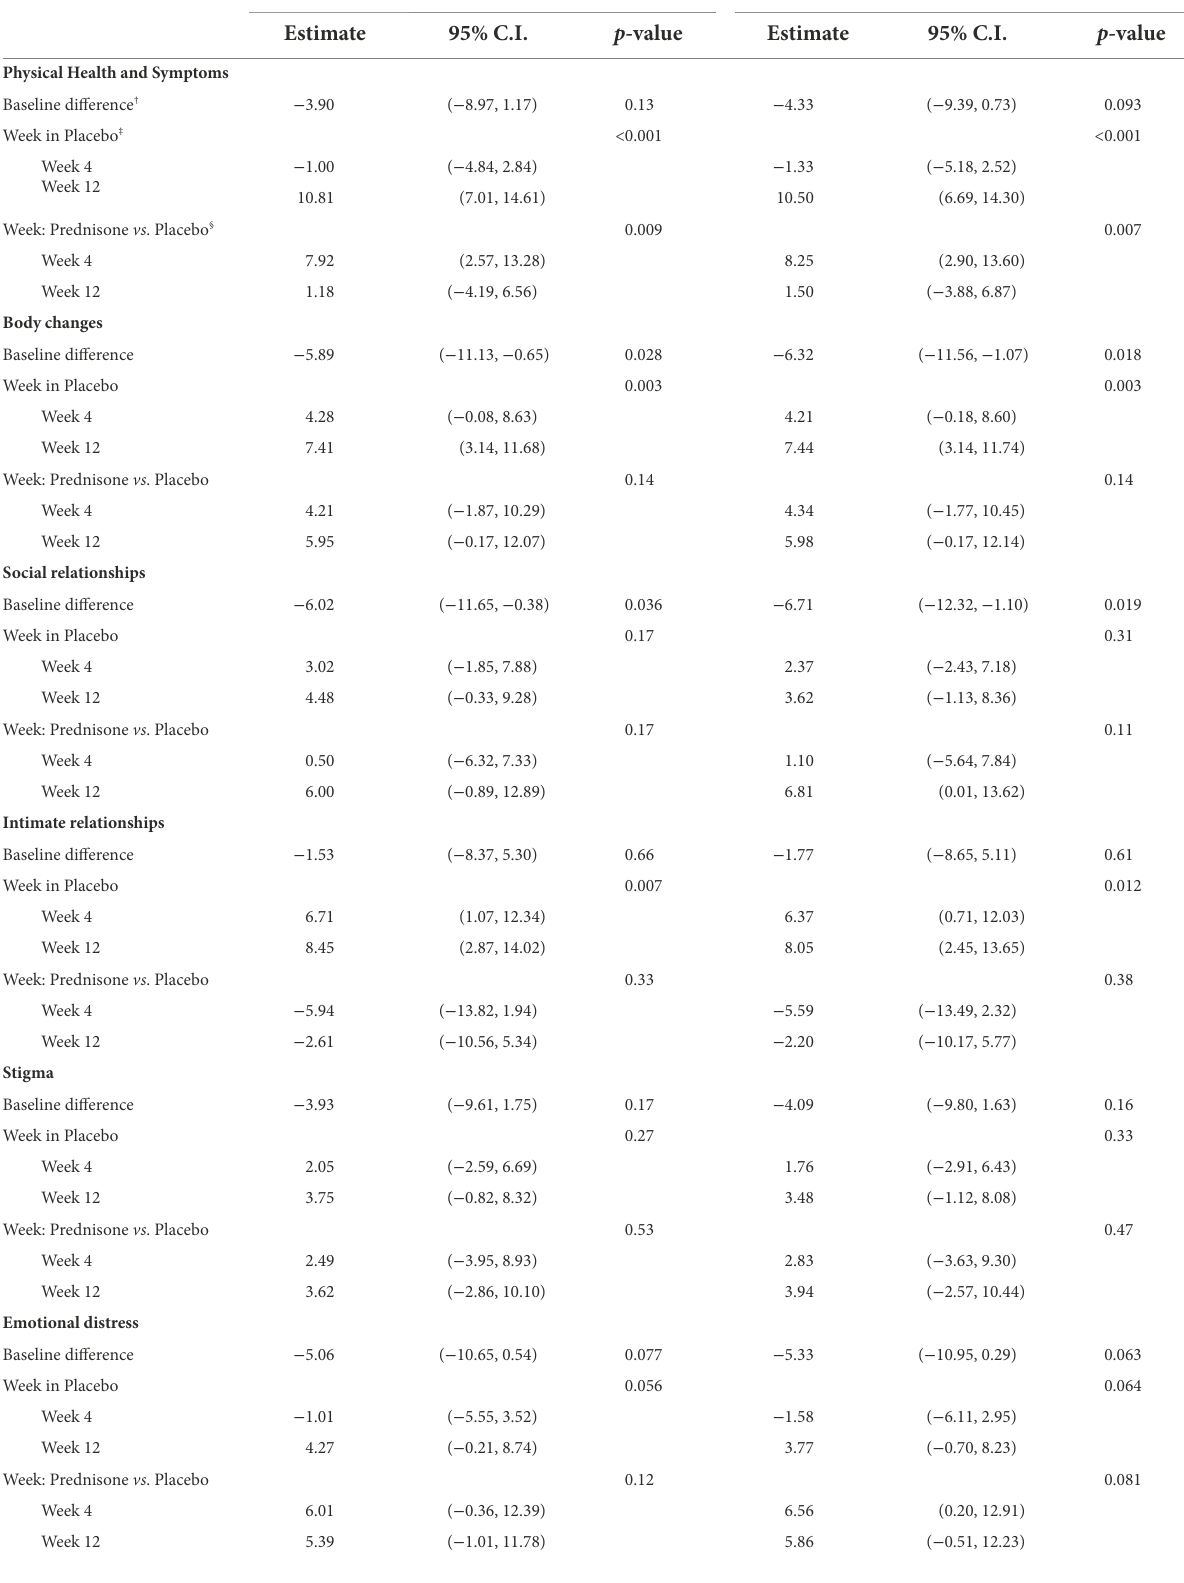
TABLE 5 Impact of prednisone on different dimensions of quality of life—ITT ( n = 240) and all-patients-treated ( n = 238) analyses. Intent-to-treat All patients Estimate 95% C.I. p -value Estimate 95% C.I. p